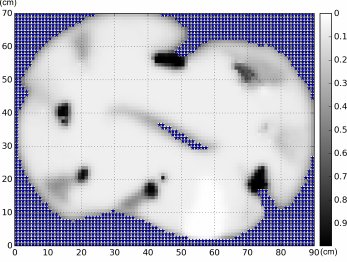
Figure 20. HMM parameter estimation of a 11 for observed